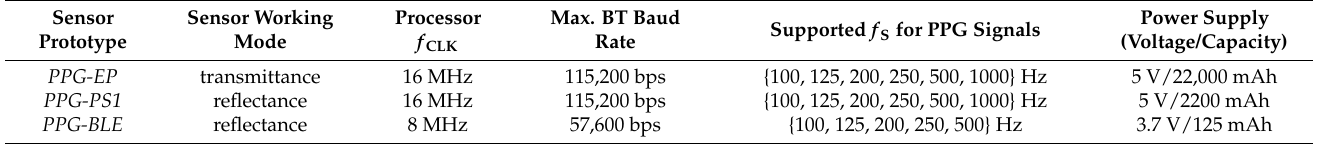
Table 2. Differences in electrical and functional parameters for three tested PPG